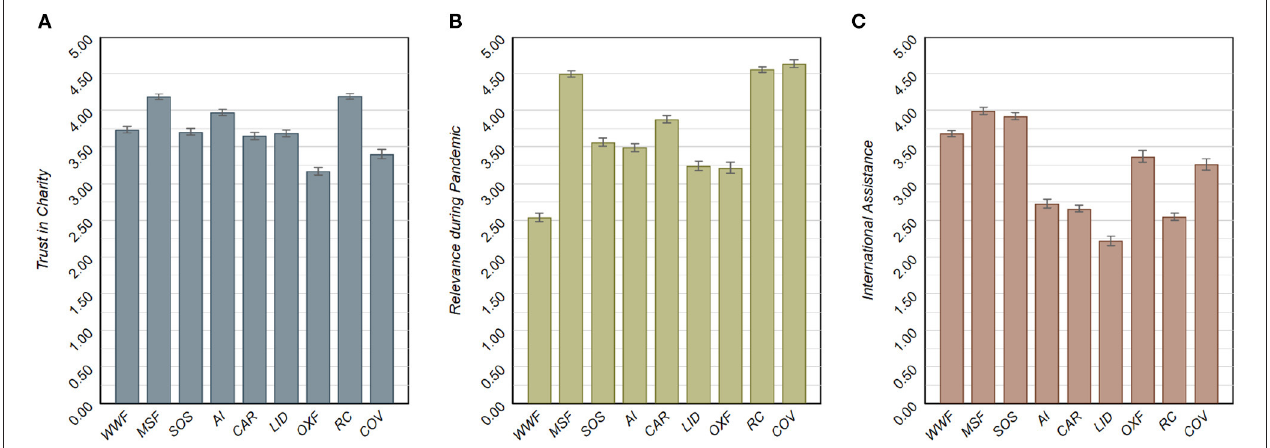
FIGURE 3 | Mean (unstandardized) survey responses on (A) trust on the charity, (B) relevance of the charity work in fighting the Covid-19 pandemic, and (C) the extent to which the work of the charity is perceived to be internationally oriented, separated by the eight charities and the WHO Covid-19 Fund . Error bars indicate 95% confidence